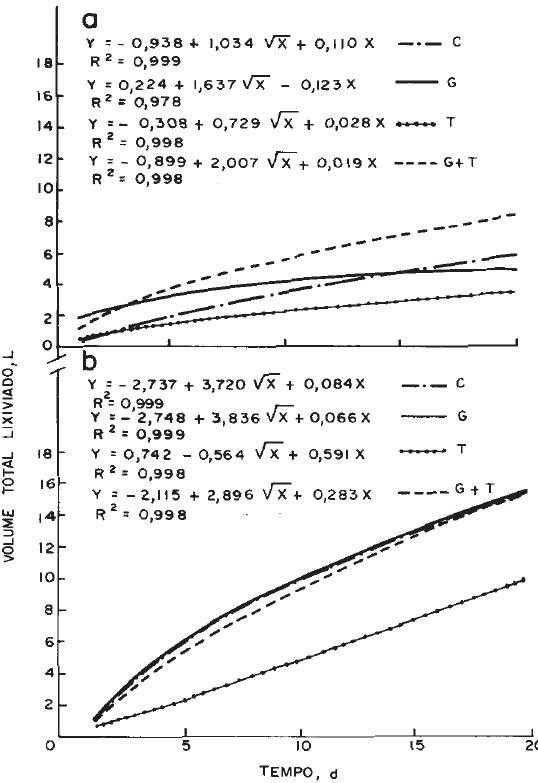
Figura 1. Volume total lixiviado em relação ao tempo de lixiviação. a: Água de chuva. b: Vinhaça. C: Controle. G: Gesso. T: Torta de